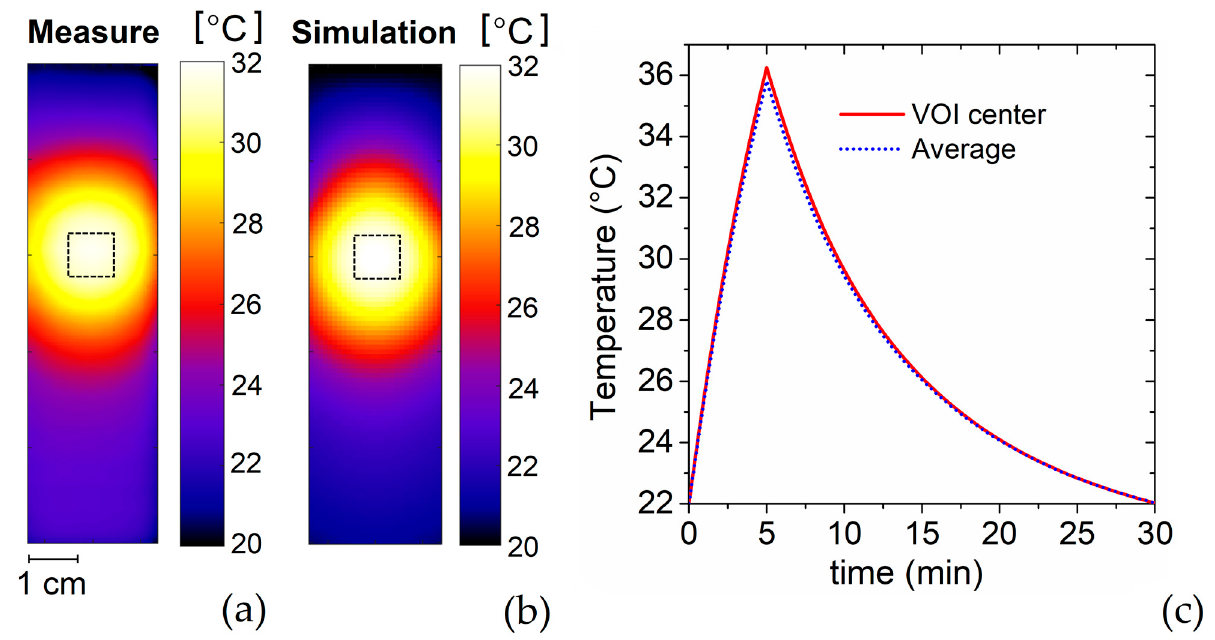
Figure 7. ( a ) Spatial distribution of temperature measured on the central longitudinal plane of the split phantom, 3 min after heating the phantom with a 5 W power for 5 min; the data are acquired with IR thermal camera. ( b ) Simulated spatial distribution of temperature. ( c ) Calculated time evolutions of the average temperature in the VOI and of temperature value in correspondence of the VOI center.